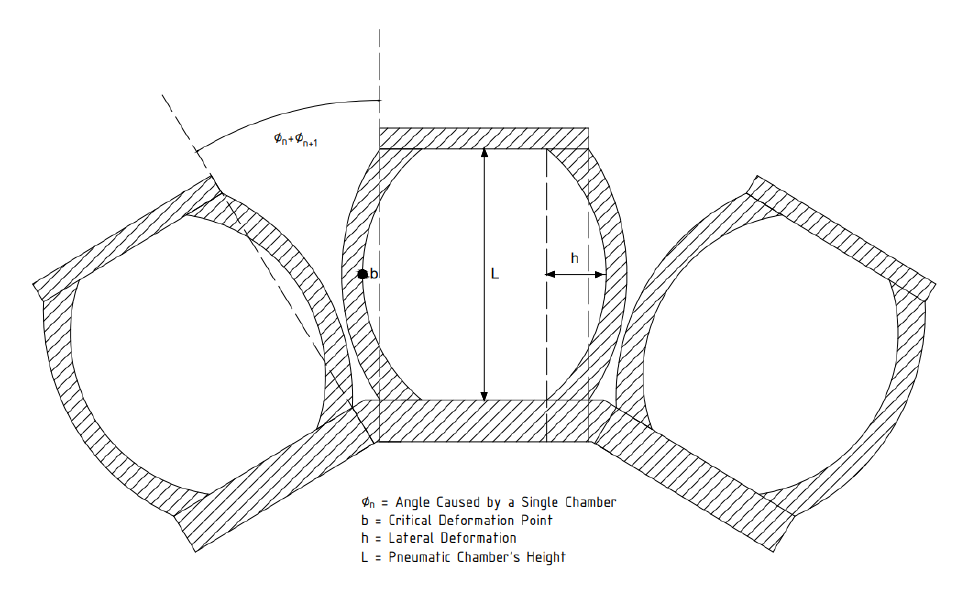
Figure 8. Physical definitions of variables in the calculation of